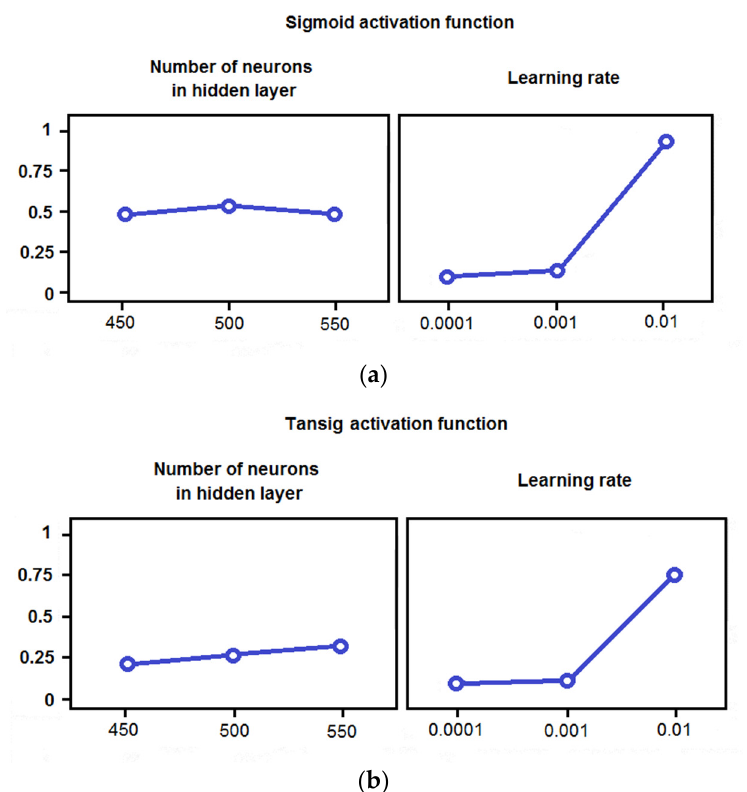
Figure 18. Main effects plots for MSE taking into account the activation function: ( a ) sigmoid function, ( b ) tansig function.